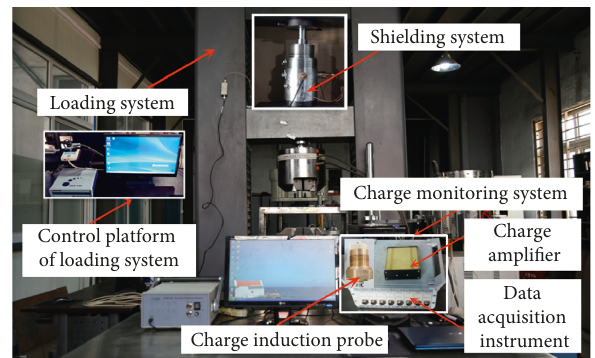
Figure 3: Experiment system.